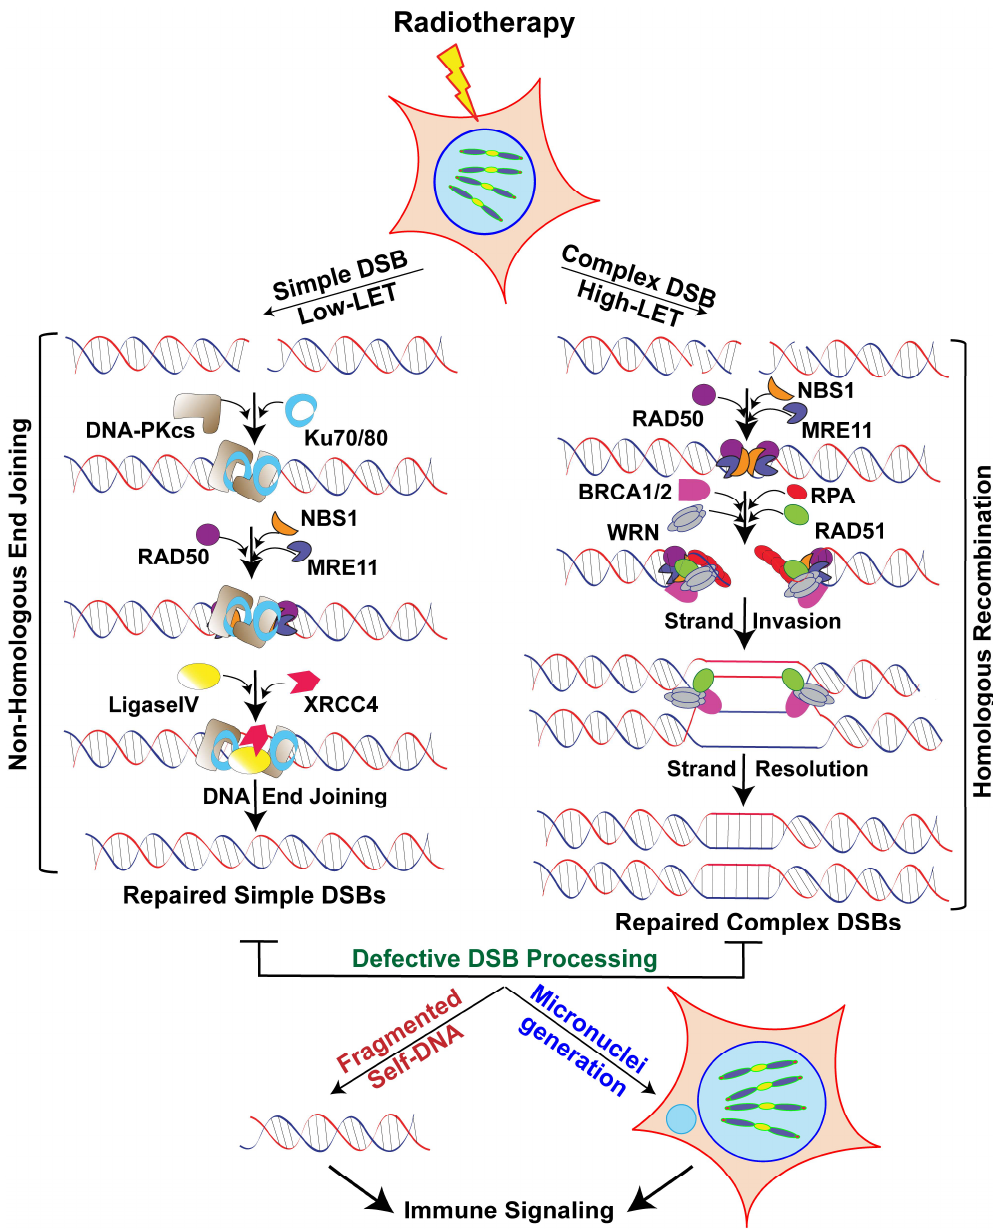
Figure 1. Schematics of the double-strand break (DSB) repair pathways after low- and high-linear energy transfer (LET) radiation. Low-LET radiation induces simple DSBs, which are repaired by non-homologous end joining pathway (NHEJ). The NHEJ process is initiated by the binding of a protein complex, the Ku70 / 80 heterodimer, to both ends of the broken DNA molecule, which, together with the catalytic subunit of the DNA-dependent protein kinase (DNA-PKcs), generates the DNA-PK complex. Non-ligatable DNA termini are processed by the MRN complex (Mre11/Rad50/Nbs1), and the DNA ends are later rejoined by ligase IV and XRCC4. High-LET radiation causes clustered DNA lesions (or multiply damaged sites). Clustered DNA damage is mostly repaired by homologous recombination (HR). HR is initiated by the resection of the DNA ends through the combined action of the MRN complex (MRE11, RAD50, and NBS1) and CtIP to generate single-stranded DNA overhangs. Subsequently, replication protein-A (RPA) binds to the newly created single-strand region before being exchanged with RAD51. The RAD51 / ssDNA complex invades the homologous template DNA, creating a temporary triple-DNA structure in which strand exchange occurs, then DNA synthesis proceeds until the second end is captured. In subsequent steps, a Holliday junction is generated to prime DNA synthesis, which is further resolved by specific